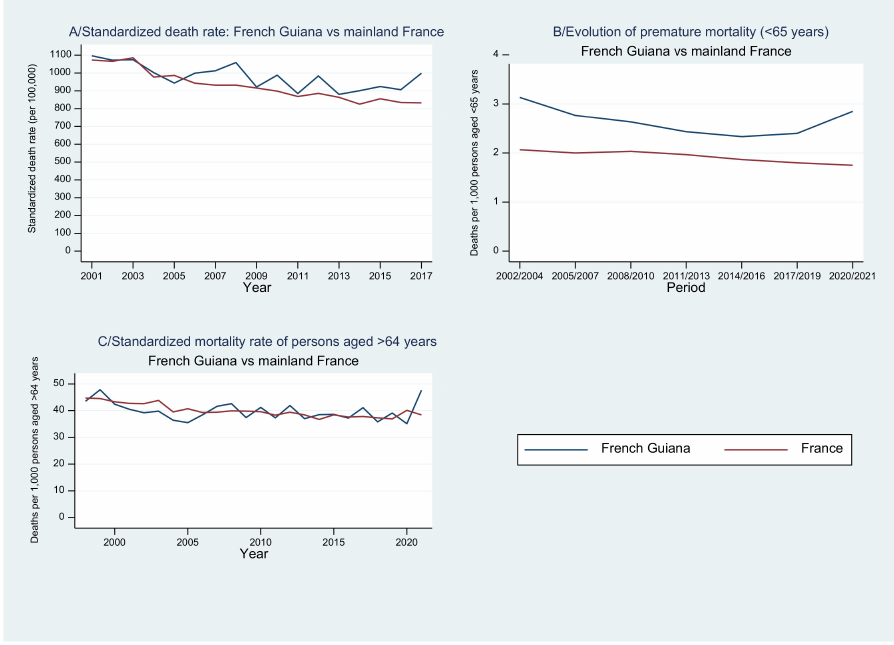
Figure 1. ( A – C ): Evolution of mortality indicators in French Guiana and mainland France: